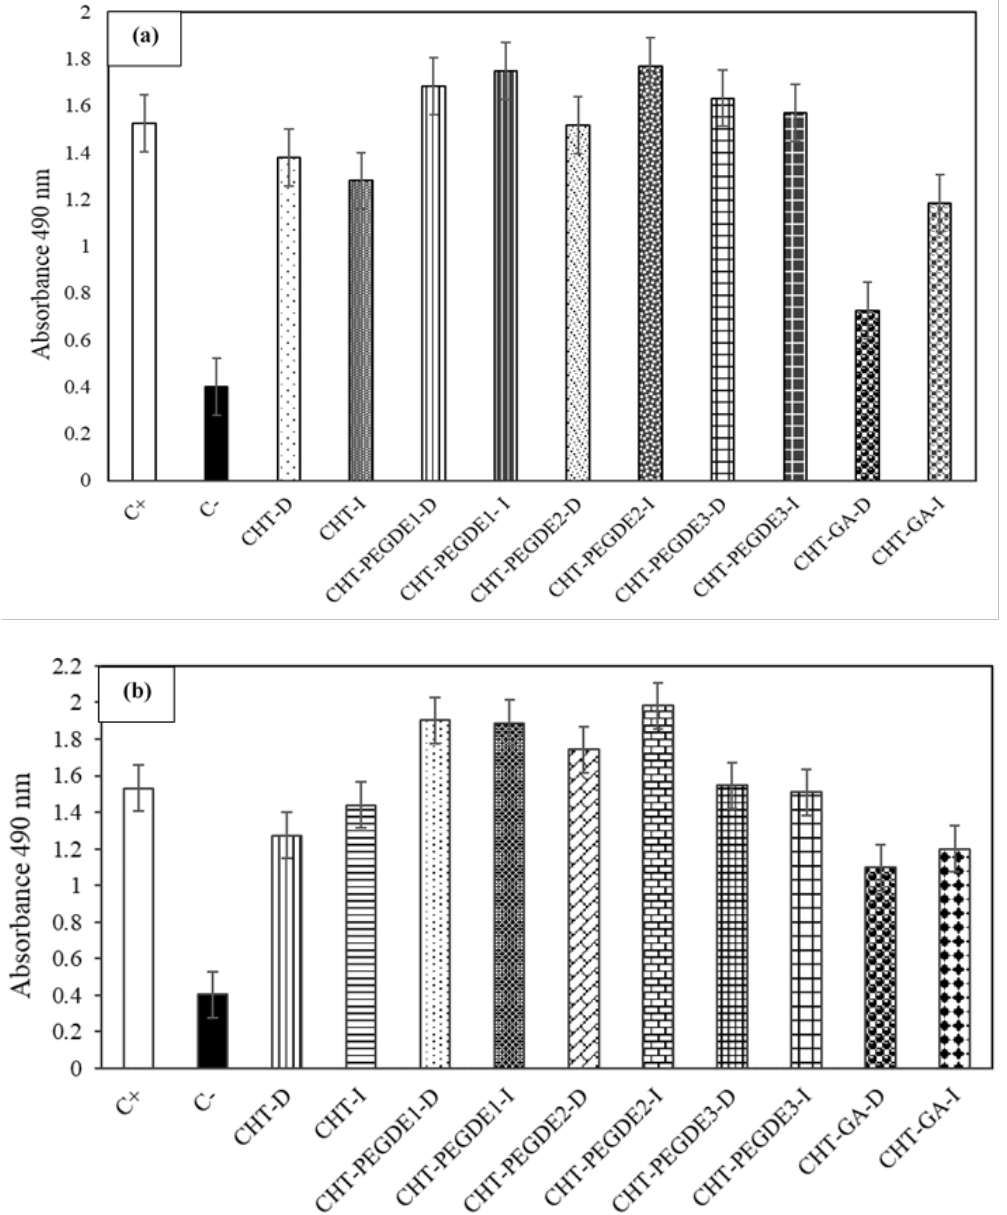
Figure 6. ( a ) Viability of osteoblast on direct (D) and indirect (I) contact with Chitosan (CHT), glutaraldehydecrosslinkedchitosan(CHT-GA),PEDGEcrosslinkedchitosan(CHT-PEDGE)at0.114mM glutaraldehyde crosslinked chitosan (CHT-GA), PEDGE crosslinked chitosan (CHT-PEDGE) at 0.114 (1), 0.228 mM (2) y 0.342 mM (3) dried at 25 ◦ C and ( b ) dried at 150 ◦ mM (1), 0.228 mM (2) y 0.342 mM (3) dried at 25 °C and ( b ) dried at 150 °C.